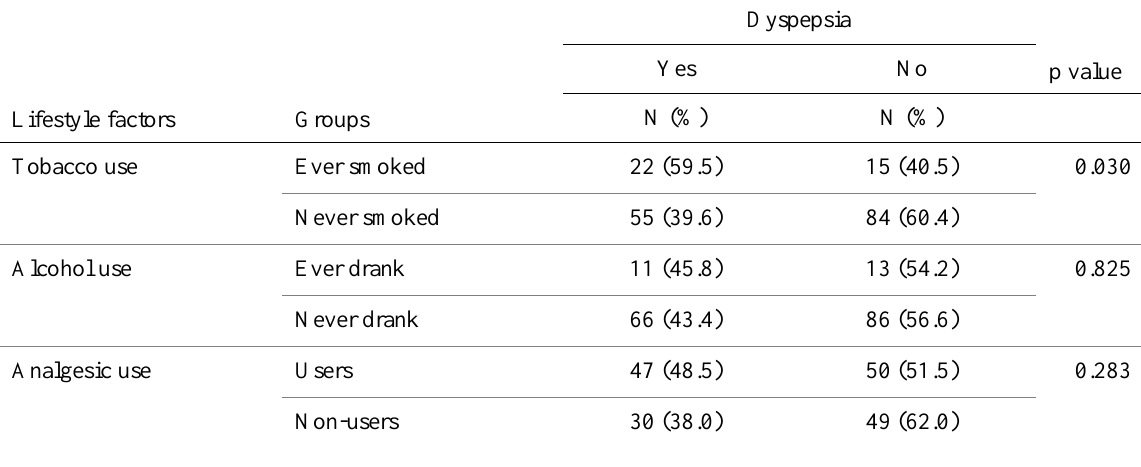
Table 4: Association between substance use and dyspepsia